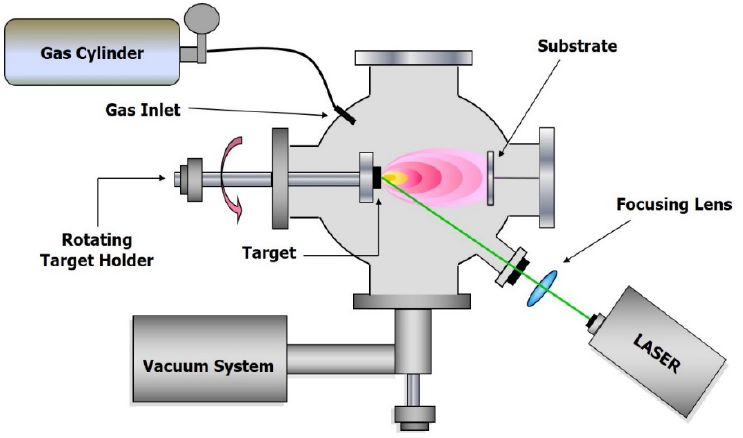
Figure 1. Experimental set-up for Pulsed Laser Deposition (PLD) experiments in vacuum or in gas pressure.